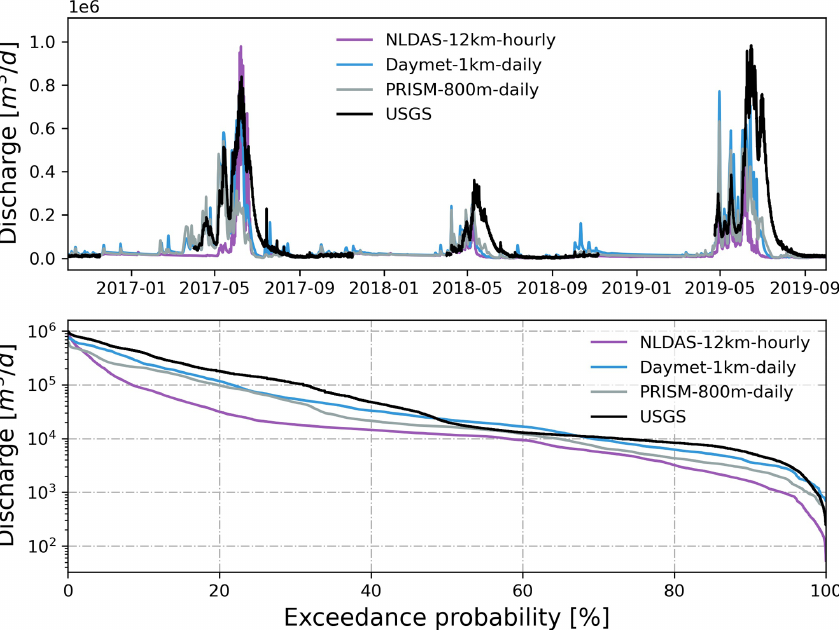
Figure 4. Simulated hourly discharge at the watershed outlet compared to USGS hourly streamflow forced by different precipitation and temperatures from each GMF. Also shown is the flow duration curve